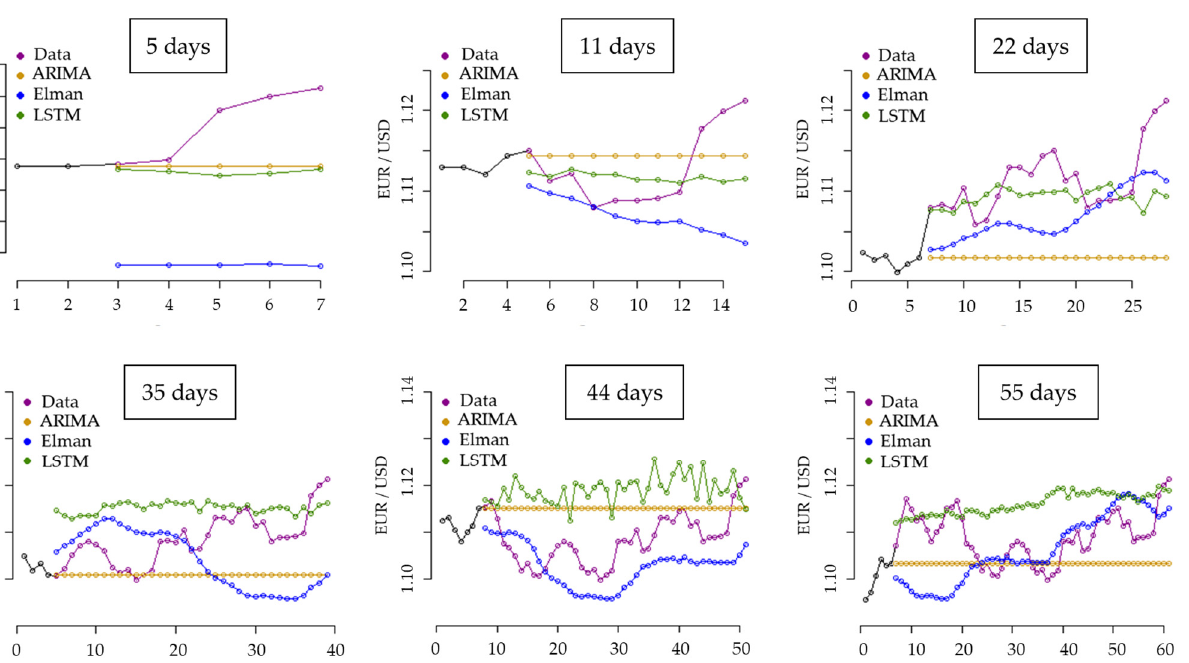
Table 1. Performance metrics for the three prediction models. Scale-Dependent Errors